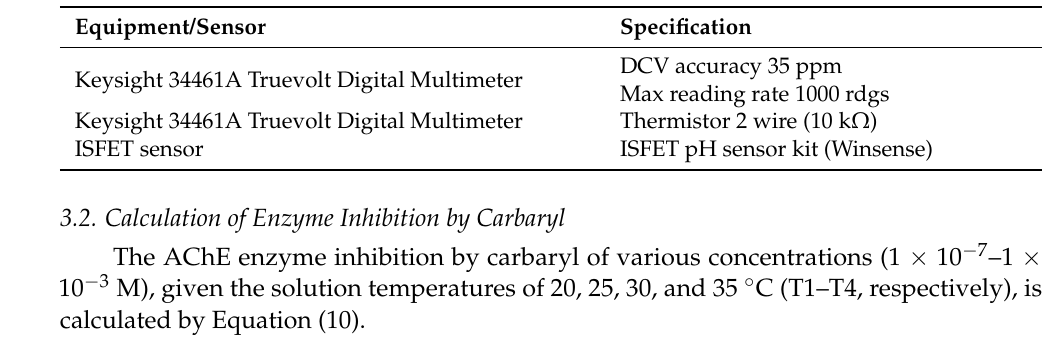
Figure 5. Diagram of the experiment setup and data collection, where V G , V D , and V S denote gate voltage, drain voltage, and source voltage, respectively. Table 1. Specification of the experimental equipment and